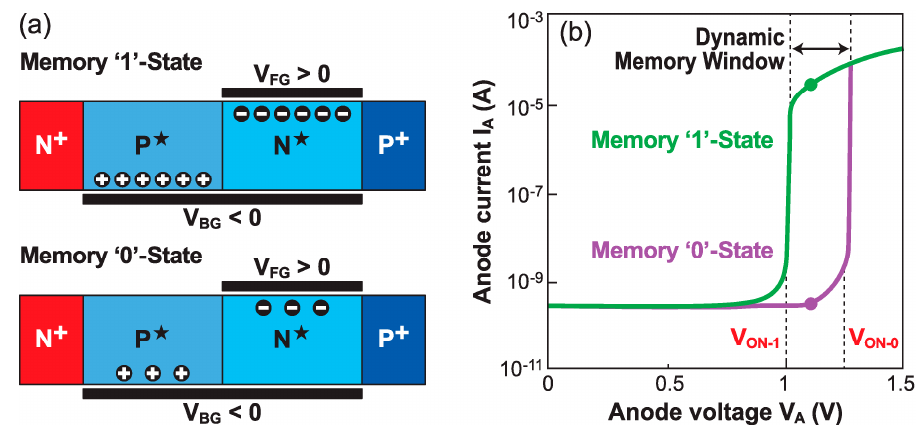
Figure 17. Operation of N-type Z 2 –FET DRAM. ( a ) Carrier populations in ‘1’ and ‘0’ memory states. ( b ) Output characteristics in ‘1’ and ‘0’ states, showing the measured currents (adapted from [34]). In any DRAM cell, four main operations are performed: read, write, erase, and hold.